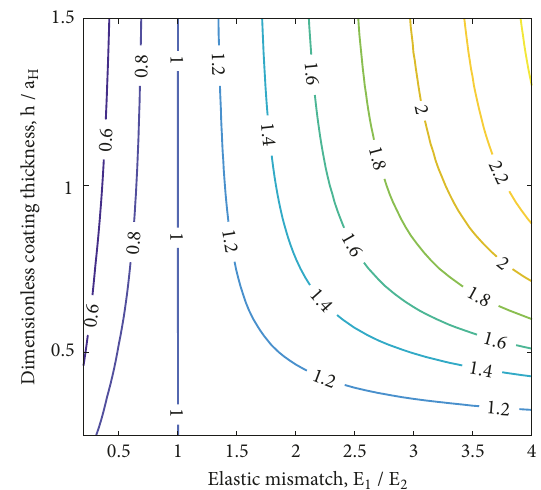
Figure 5: Iso-contours of dimensionless maximum pressure 𝑝/𝑝 𝐻 .